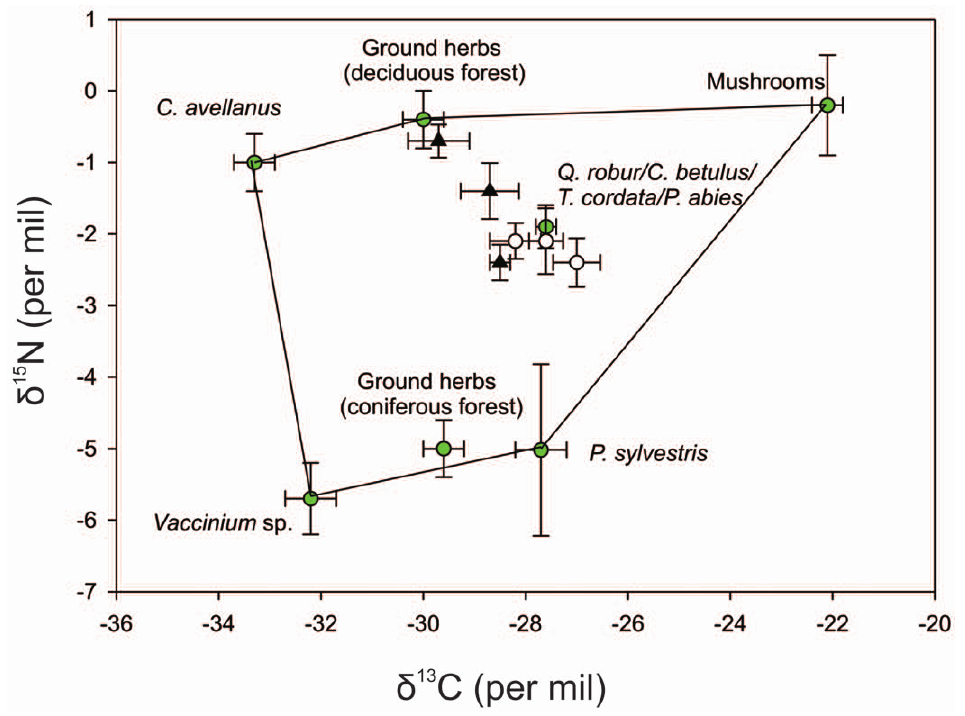
Figure 1. Convex mixing polygon (excluding lichens) used to model potential rodent dietary inputs. Vegetation groups (green circles) correspond to those listed in Tables 1 and S2. Triangles are bank voles and circles are yellow-necked mice (see Figure 2 for corresponding intermediate, mast and post-mast categories depicted).